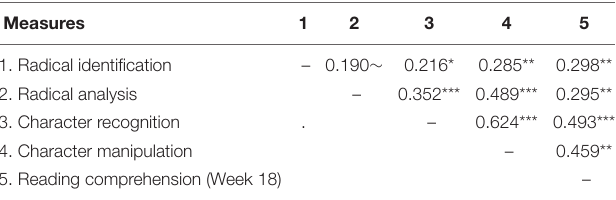
TABLE 3 | Correlations among radical identification, radical analysis, character recognition, character manipulation, and reading comprehension ( N = 103).